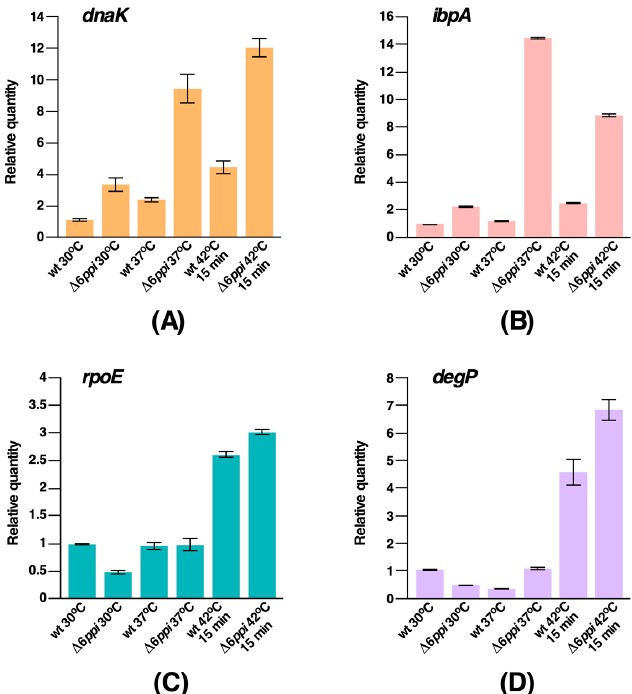
Figure 3. ∆ 6 ppi bacteria exhibit constitutive elevated transcription of RpoH-regulated heat shock genes Figure 3.  6 ppi bacteria exhibit constitutive elevated transcription of RpoH ‐ regulated heat shock but reduced level of RpoE-transcribed genes at 30 and 37 ◦ C. qRT-PCR analysis of mRNA isolated from genes but reduced level of RpoE ‐ transcribed genes at 30 and 37 °C. qRT ‐ PCR analysis of mRNA isolated from the wild type (wt) and its  6 ppi derivative bacteria grown up to an OD 600 of 0.2 in the wild type (wt) and its ∆ 6 ppi derivative bacteria grown up to an OD 600 of 0.2 in M9 medium at either M9 medium at either 30 or after shift to LB at 37 °C. In parallel, total RNA was extracted 30 or after shift to LB at 37 ◦ C. In parallel, total RNA was extracted after heat shock for 15 min at 42 ◦ C. after heat shock for 15 min at 42 °C. Quantification of data for the dnaK gene (Panel A ), the Quantification of data for the dnaK gene (Panel A ), the ibpA gene (Panel B ), the rpoE gene (Panel C ) and ibpA gene (Panel B ), the rpoE gene (Panel C ) and the degP gene (Panel D ). the degP gene (Panel D